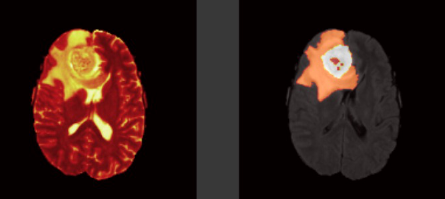
Figure 2. Brain tumor modalities. Left image: T2-weighted and Right image: Ground